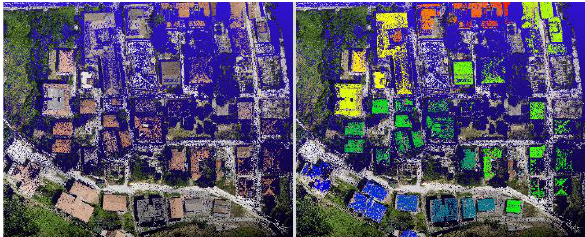
Figure 6 Sparse point cloud, left ; building hypothesis (coloured) overlaid on the sparse point cloud ,